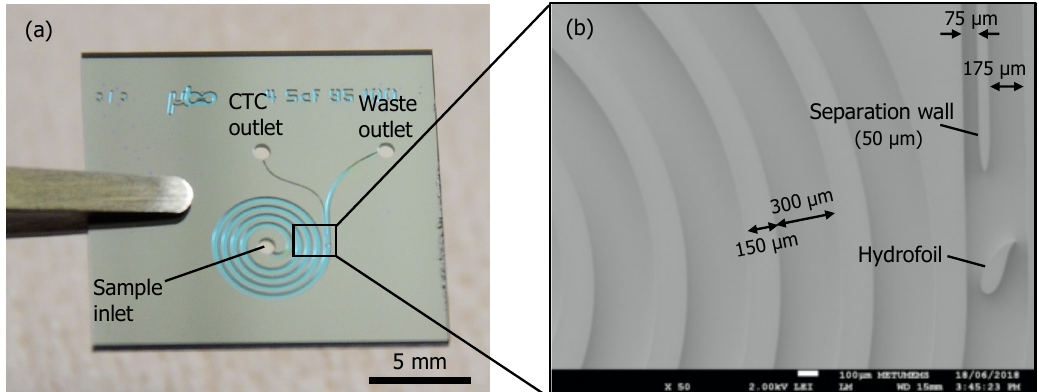
Figure 3. ( a ) Fabricated silicon/glass chip with four loops of a spiral channel and a hydrofoil at the downstream of the spiral channel. Channels were patterned by using deep reactive-ion etching (DRIE) of silicon and sealed with glass by anodic bonding. The CTC and waste outlets and the sample inlet are indicated. ( b ) SEM image of the section with the hydrofoil.